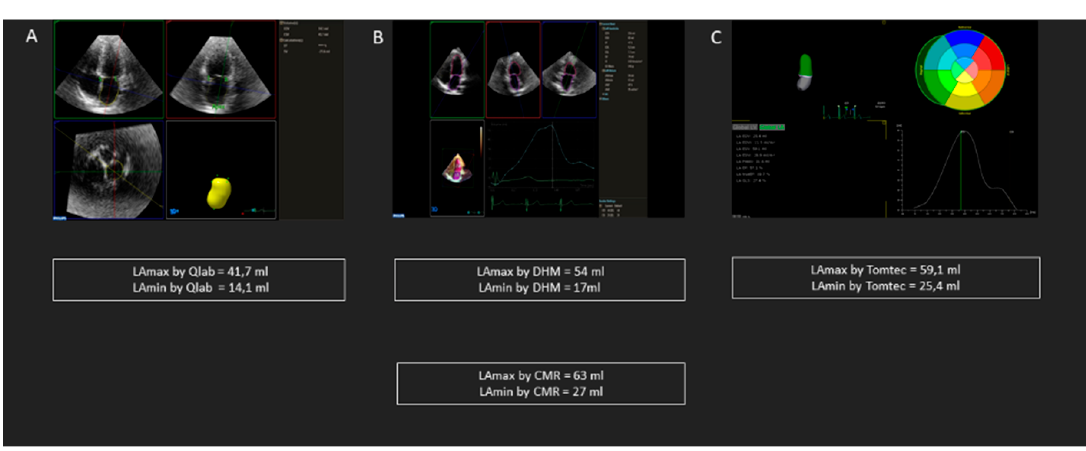
Table 2. Comparison between different three-dimensional echocardiographic modalities.